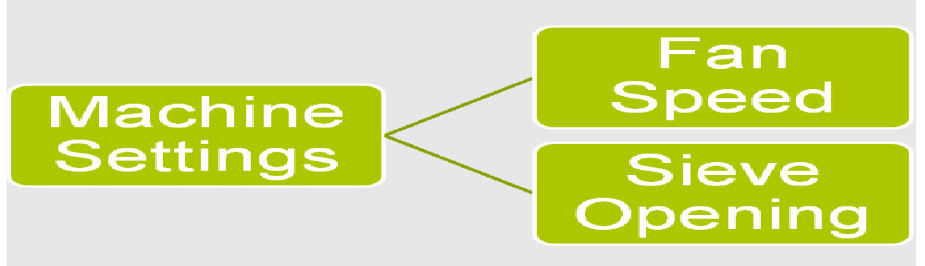
Figure 4. Machine parameters that affect grain cleaning losses.